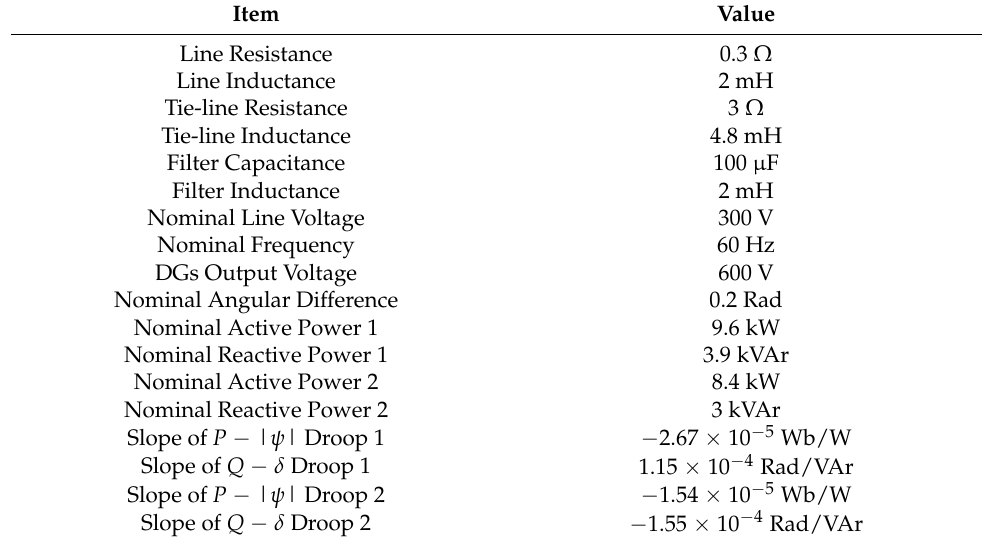
Table 2. Microgrid and control parameters.